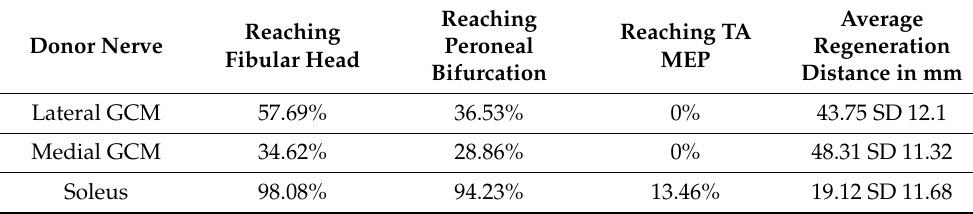
Table 2. Nerve transfer comparison showing the percentage of extremities in which the individual nerve transfers were able to reach the fibular head, the peroneal nerve bifurcation, the tibialis anterior (TA) motor entry point (MEP) as well as the mean regeneration distance for each nerve transfers to reach the targeted